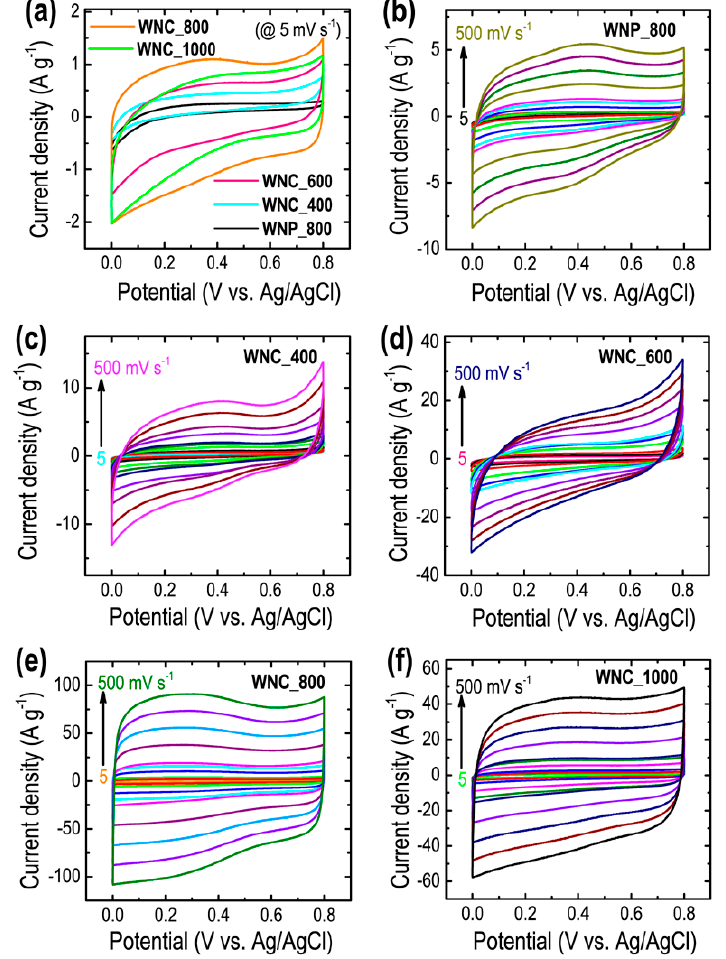
Figure 5. ( a ) Comparison of cyclic voltammetry (CV) profiles of all the prepared carbons at 5 mV s − 1 , and the CV profile vs. scan rates. ( b ) WNC_800, ( c ) WNC_400, ( d ) WNC_600, ( e ) WNC_800, and ( f )